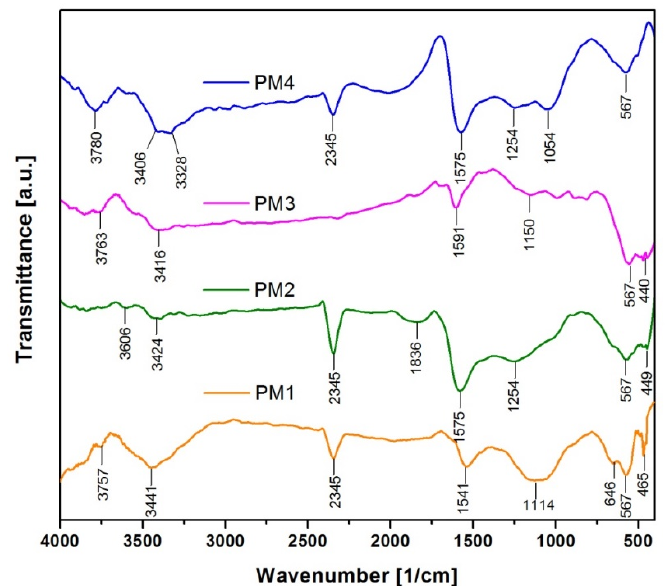
Figure 2. FT-IR spectra of magnetic nanocomposites.